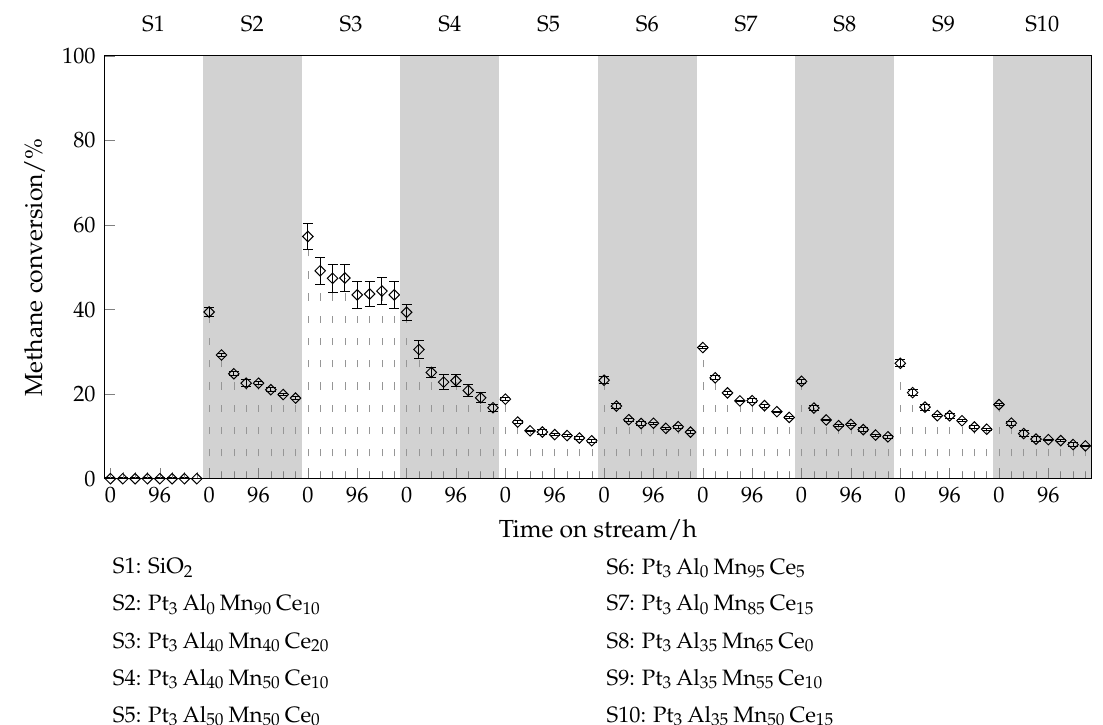
Figure 17. Methane conversion as function of time on stream up to 168h of selected samples from systems Pt 3 Al a Mn b Ce c . 0.5vol.% CH 4 , 9.0vol.% O 2 , 12.5vol.% CO 2 , 0.001vol.% SO 2 , 12.5vol.% H 2 O, balance N 2 ; 450 ◦ C, WHSV = 72,000mL/ ( gh ) .Error bars represent standard deviation ( n = 3) as given by Equation 2.